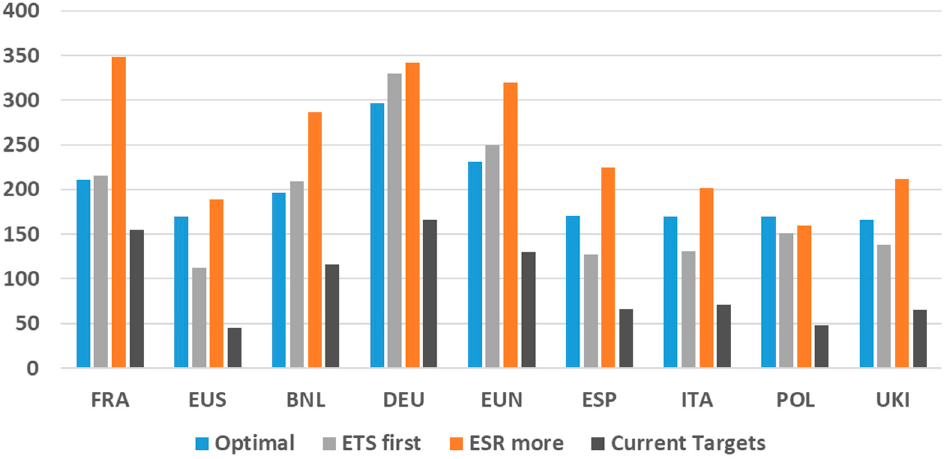
Figure A5. EU27 + UK regional absolute weighted CO 2 prices in 2030 [€2020].